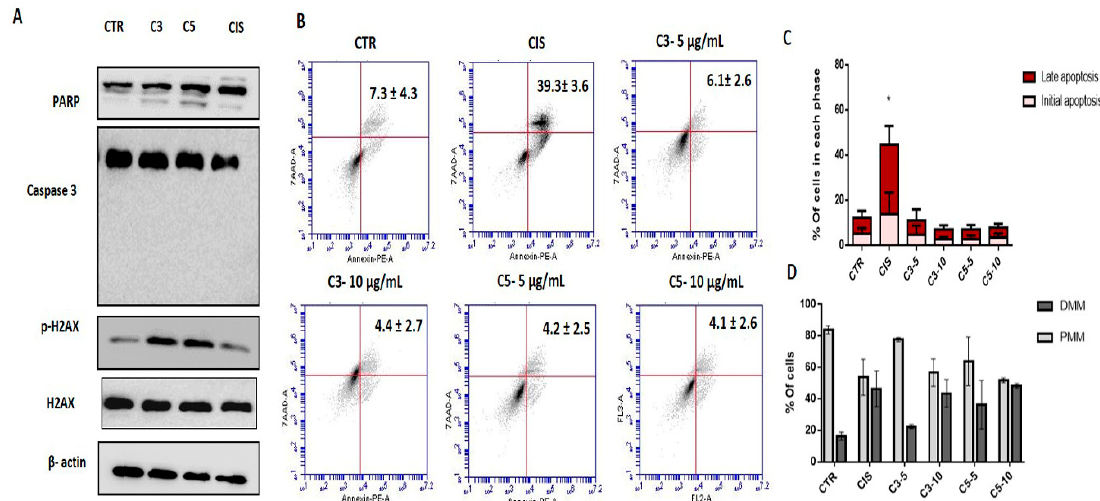
Figure 4. Apoptosis evaluation in SiHa cells upon C3 and C5 compounds. ( A ) Western blot of PARP (Poly (ADP-ribose) polymerase), caspase 3, and H2AX (H2A histone family member X) proteins ( B ) Flow cytometry for SiHa cells. ( C ) Comparison of apoptotic cells upon C3 and C5 treatment. There was a significant increase for cells in apoptosis only for cisplatin (CIS) * p = 0.0282 ( D ) Depolarization of the mitochondrial membrane after treatment with C3 and C5 and cisplatin in the SiHa cell line. C3: Ethyl acetate fraction; C5: Fraction enriched in acetogenin; Cis: cisplatin; DMM: Depolarized mitochondrial membrane; PMM: Polarized mitochondrial membrane. p < 0.05). C3: Ethyl acetate fraction; C5: Fraction enriched in acetogenin; Cis: cisplatin.